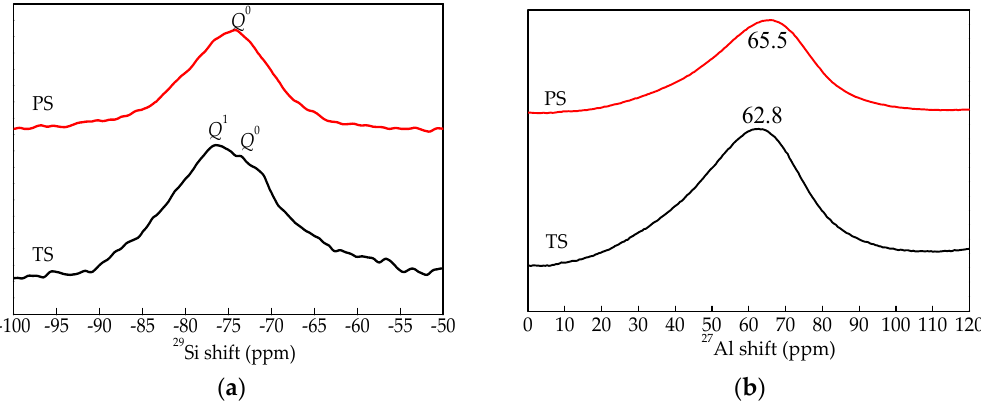
Figure 6. 29 Si and 27 Al NMR spectroscopy for two kinds of water-quenched slag. ( a ) 29 Si NMR spectroscopy; ( b ) 27 Al NMR spectroscopy.